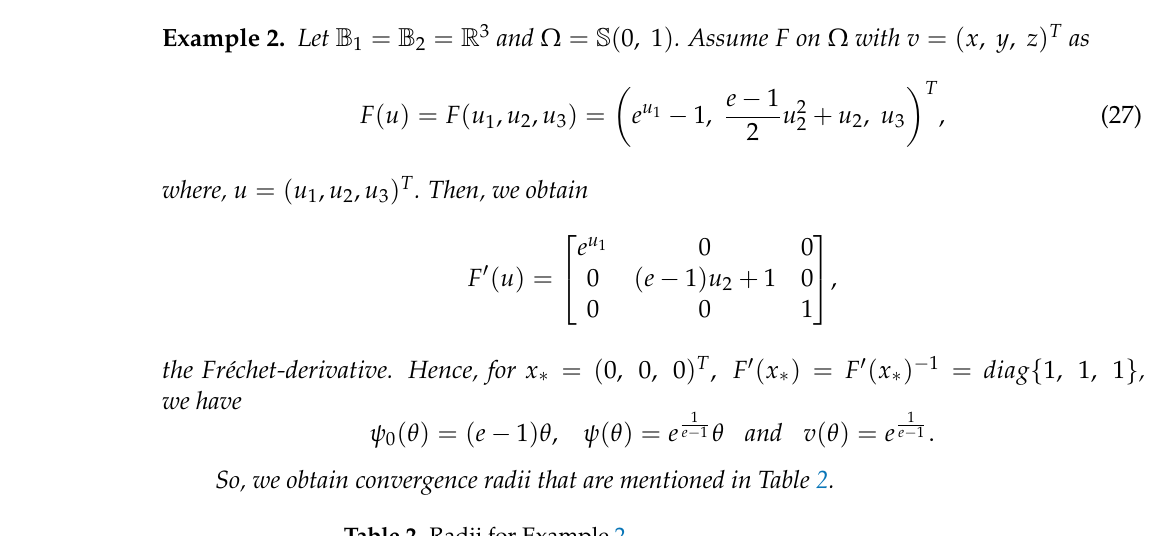
Table 2. Radii for Example 2.